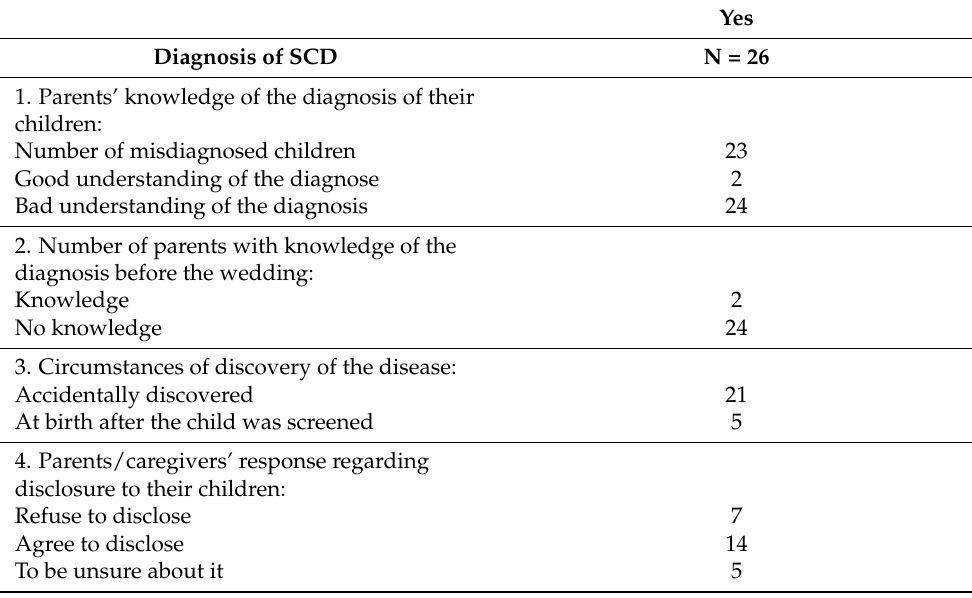
Table 3. Proportion of responses given by parents/caregivers regarding the diagnosis of SCD and the circumstances of